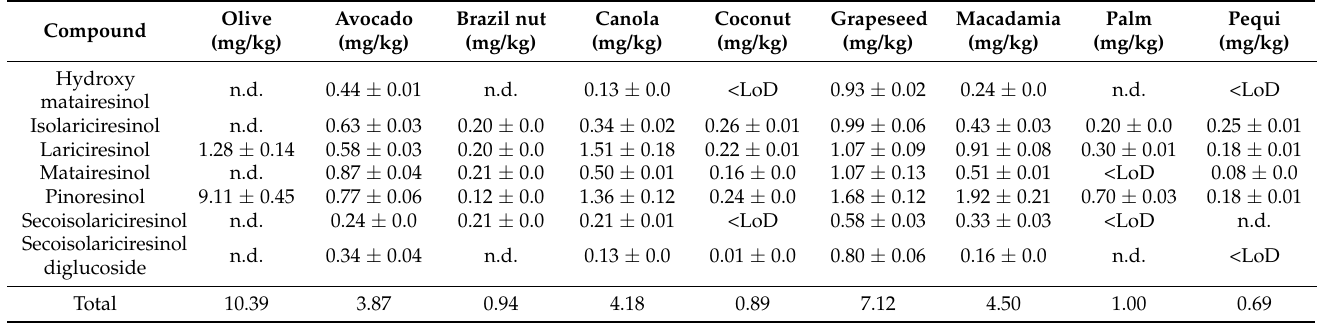
Table 3. Concentration levels of lignans in edible gourmet oils by HPLC-MS/MS, expressed as